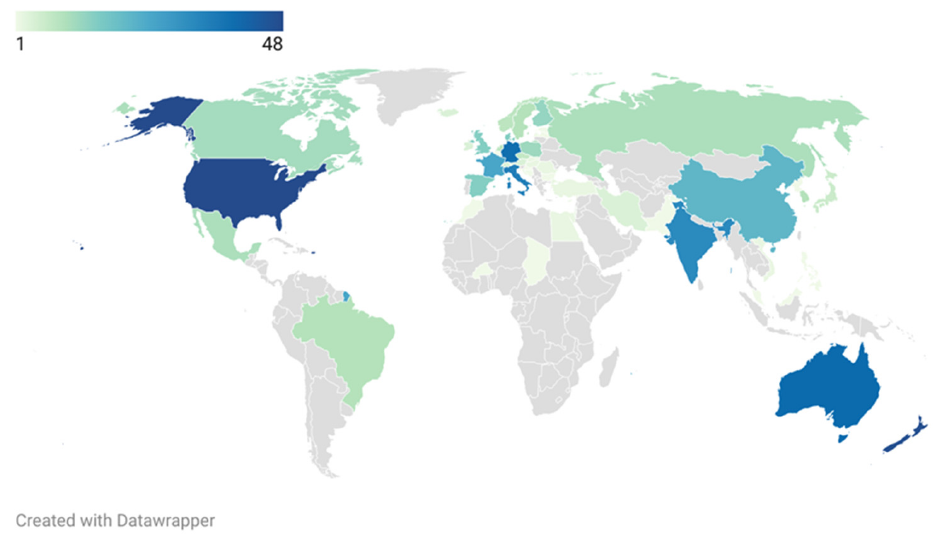
Figure 5. Contribution by country to research documents on the A2 β -casein research field in the period